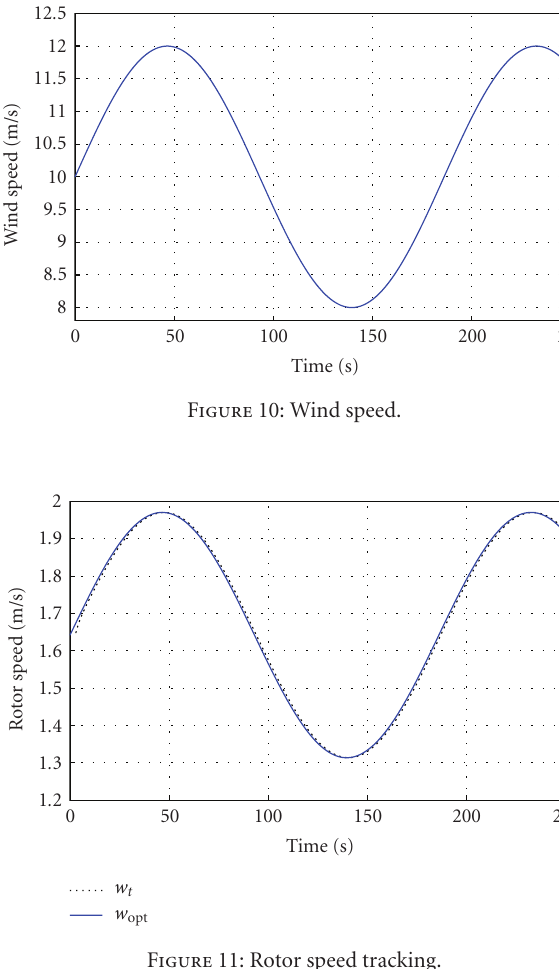
Figure 11: Rotor speed